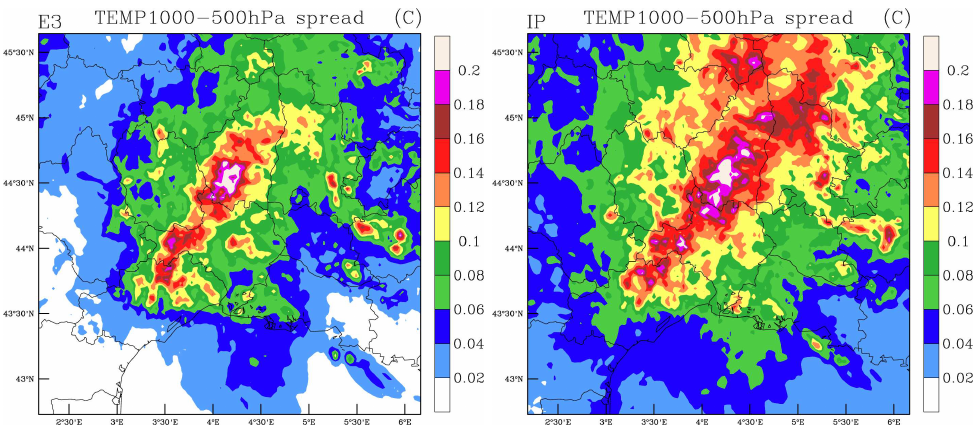
Fig. 12. Comparison of the 12:00UTC, 20 October temperature spread for the Gard-H´erault case between the microphysical perturbation ensemble E3 (left) and initial perturbation ensemble E5 (right).